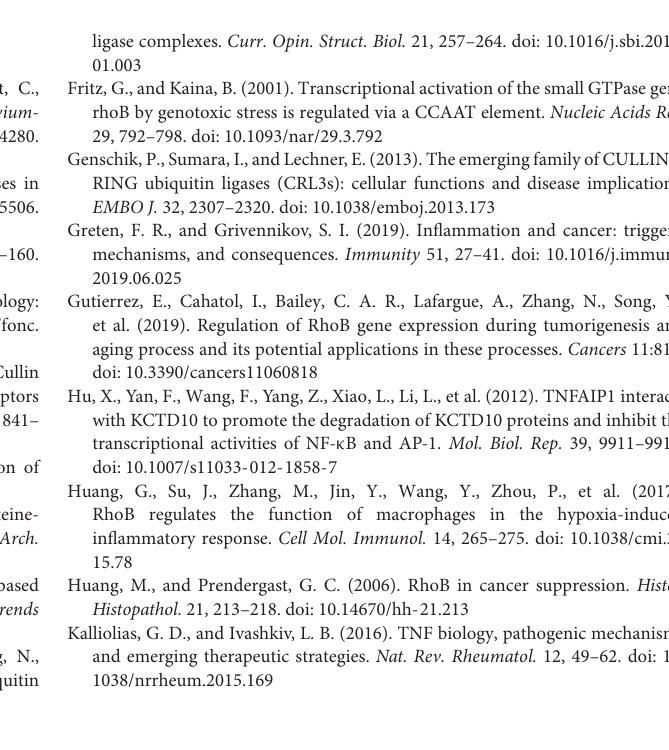
Supplementary Figure 1 | Downregulation of TNFAIP1 did not affect the protein level of Cullin3 in Huh7 or HepG2 cells. Cells were transfected with ctrl (control), TNFAIP1-1 or TNFAIP1-2 siRNA for 96 h, and cell lysates were harvested for western blot analysis. Supplementary Figure 2 | Knocking down TNFAIP1 and KCTD10 simultaneously resulted in the more accumulation of RhoB compared with TNFAIP1 and KCTD10 knockdown alone. Huh7 and HepG2 cells were transfected with indicated combination of ctrl (control), TNFAIP1 and KCTD10 siRNA for 96 h and cell lysates were harvested for western blot